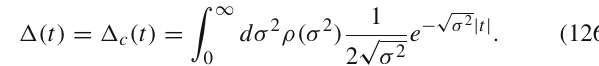
function is obtained as the difference (cid:6) p ( t ) = (cid:6)( t ) − (cid:6) c ( t )